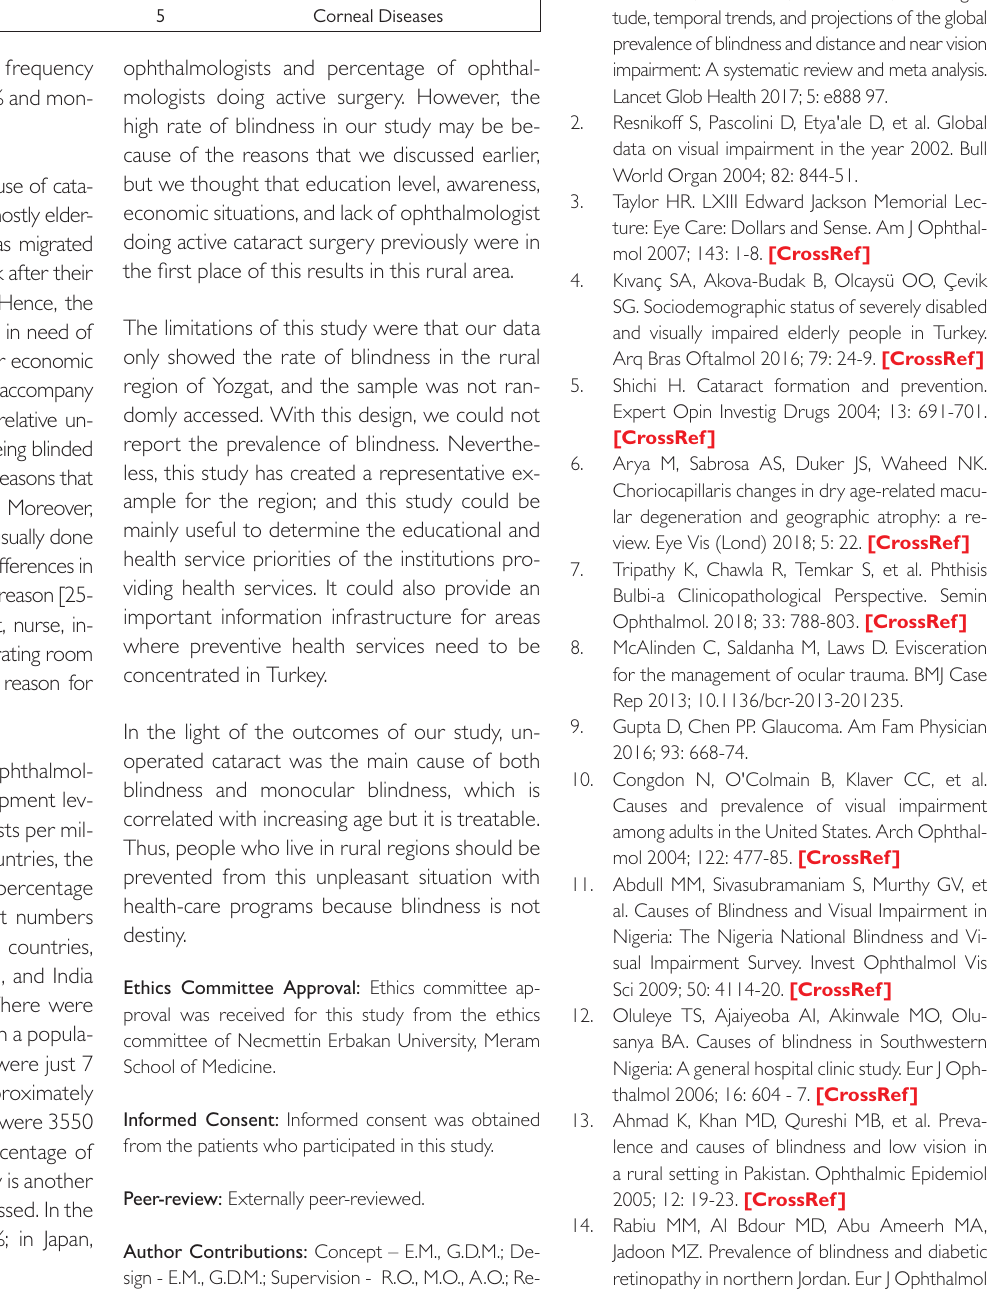
racts become blind. In this study, the frequency of cataract causing blindness was 42% and mon- ocular blindness was 27%.